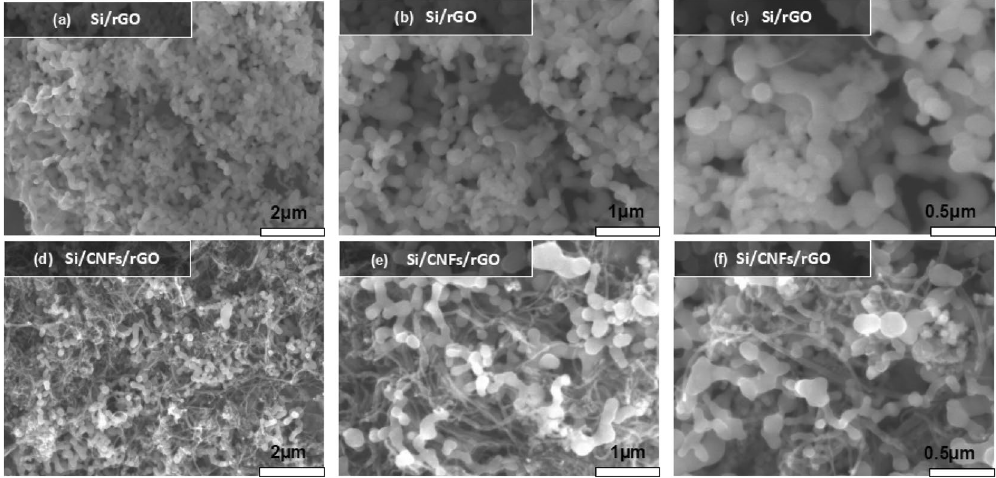
Figure 2. SEM images of the ( a – c ) Si/rGO and ( d – f ) Si:CNF/rGO = 1:1